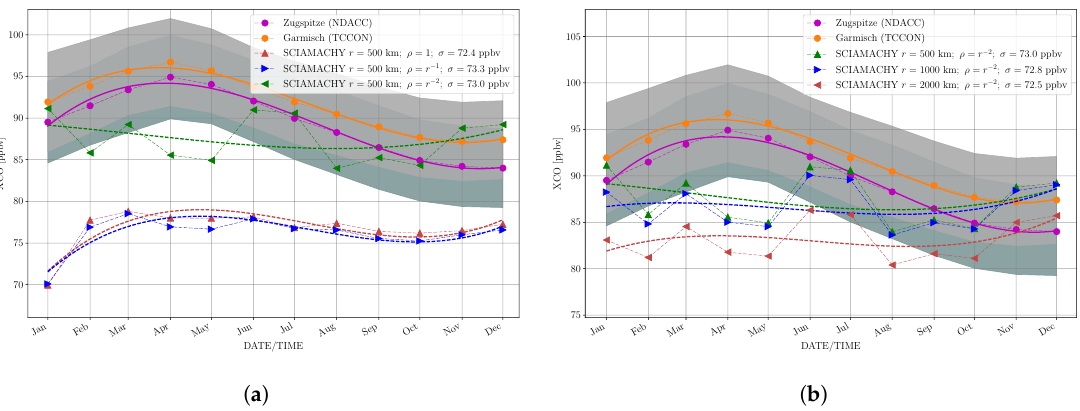
Figure 13. The effect of distance weighting on SCIAMACHY ˆxCO with respect to Garmisch (2007–2011) and Zugspitze (2003–2011) reference sites. The solid and dashed lines show the three-degree polynomial fit on the individual observations and σ xCO sb . ( a ) Weighting of measurements within a given ≡ (cid:104) (cid:105) e distance leads to better agreement with g-b references; ( b ) The effect of weighting partly reveals the annual cycle at the reference sites. However, the amplitude is low and a slightly negative offset remains. Note that the standard deviation of the s-b measurements is included in the